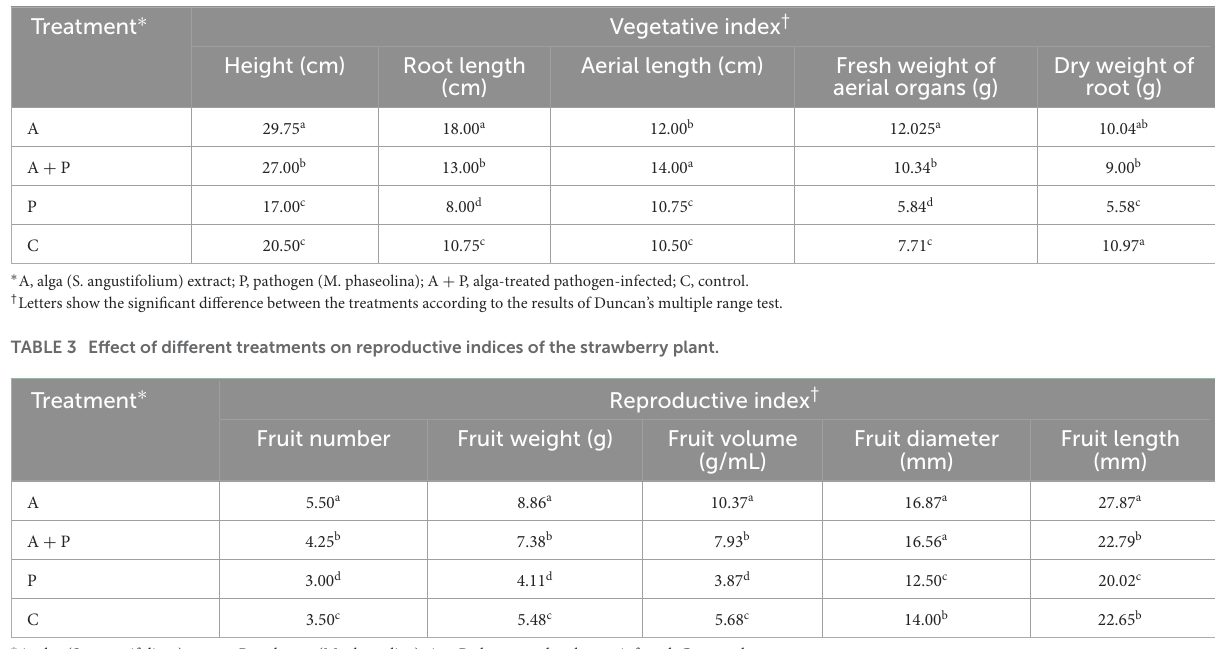
TABLE 2 Effect of different treatments on vegetative indices of the strawberry plant.